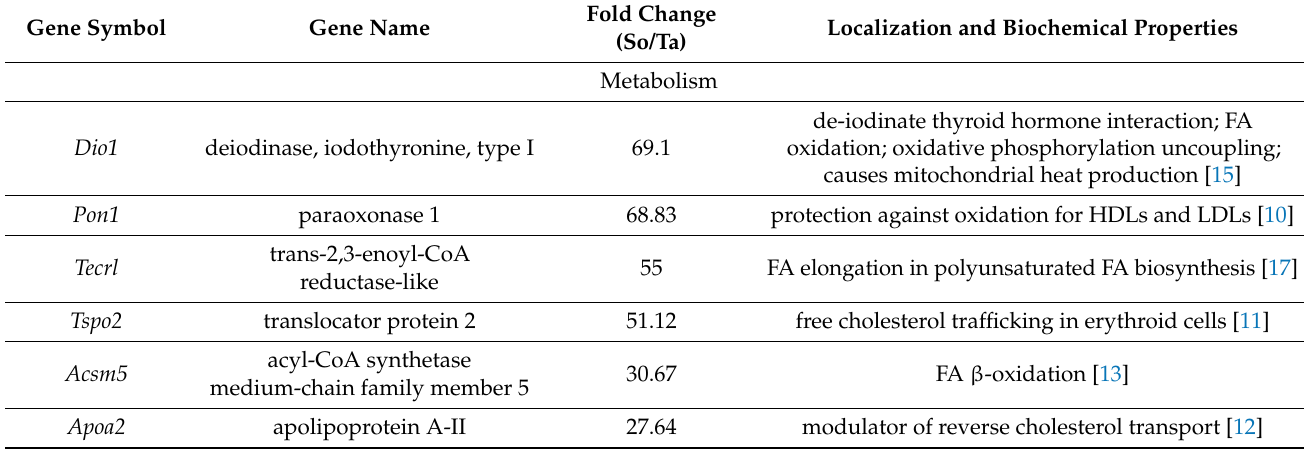
Table 1. DE genes associated with lipid, amino acid, and one-carbon metabolic